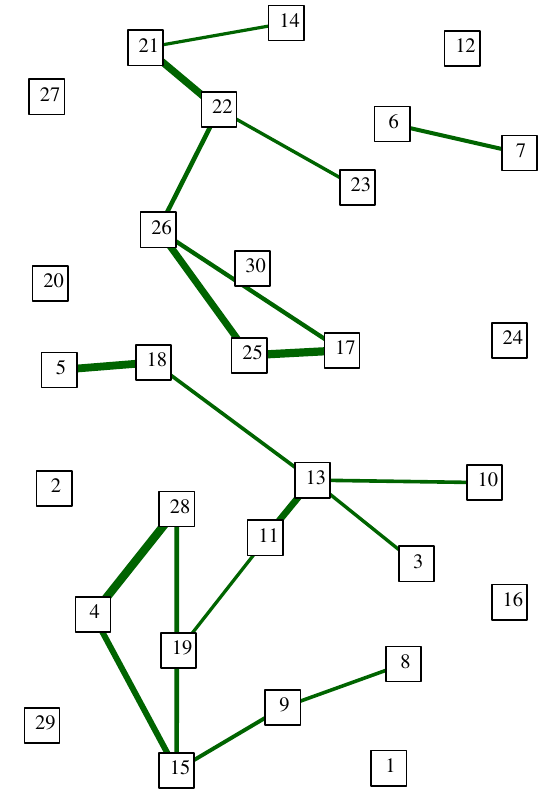
FIG. 1. Correlation matrix for all FCI items. Lines represent correlations with j r j > 0 . 3 . Line thickness represents the size of the correlation. Solid (green) lines represent positive correlations; dashed (red) lines negative correlations. No negative correlations were